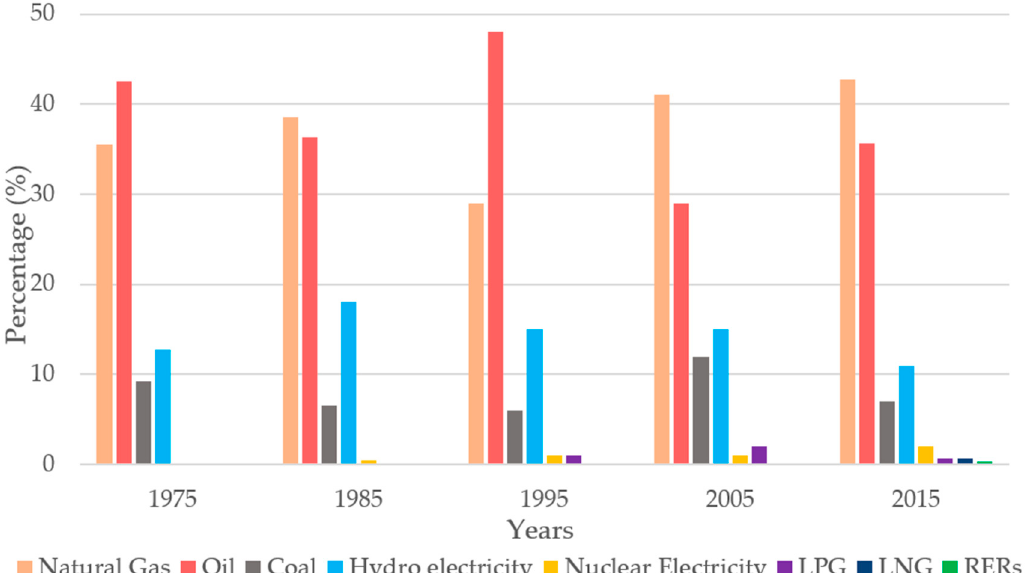
Figure 7. Energy Mix of Pakistan showing heavy dependence on natural gas and oil over the past four decades [32].